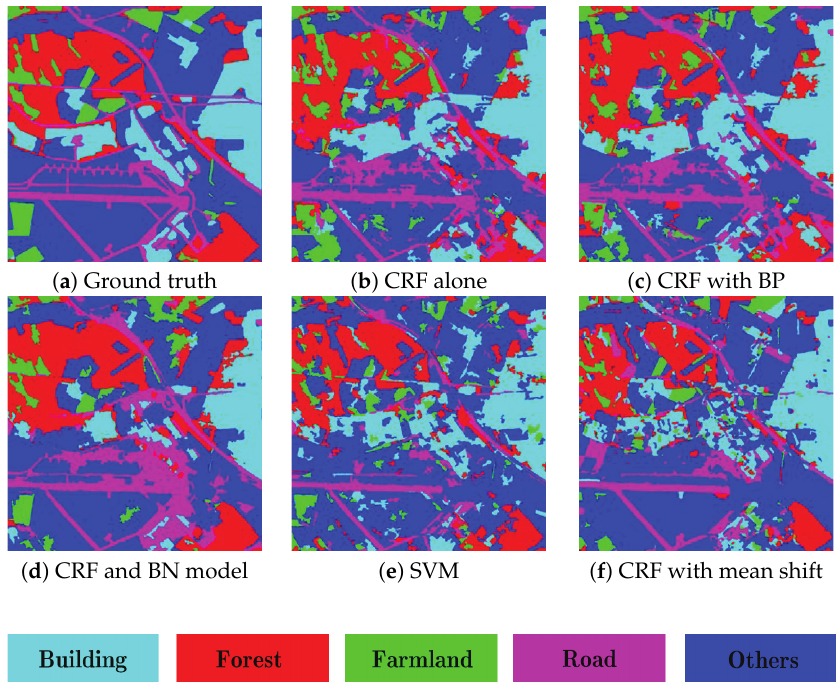
Figure 9. Classification results of ESAR image. ( a ) The ground truth; ( b – d ) the results by the CRF model alone, CRF with boundary prior knowledge, CRF and the BN model, respectively; ( e , f ) the results by SVM and CRF with mean shift.